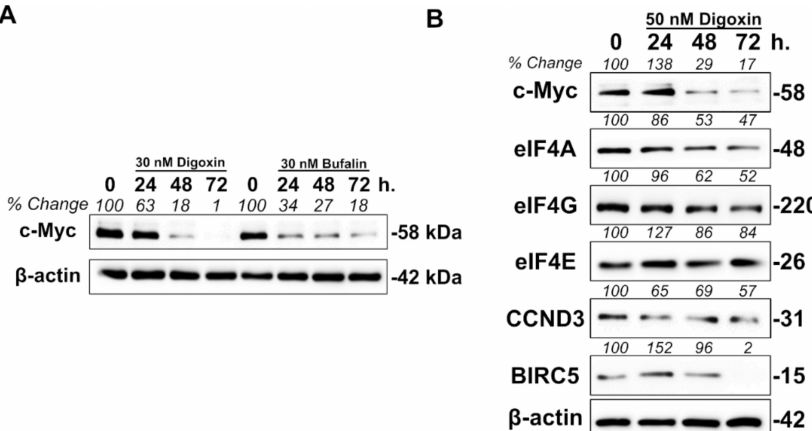
Figure 4. Cardiac glycosides modulate eIF4A expression levels through c-MYC ( A ). Western blot of BT20 cells following treatment with 30 nM of digoxin or bufalin for the indicated times. Band intensities were calculated by densitometry based on the ratio of c-MYC normalized to β -actin with 0 h set to 100 for each compound. ( B ). Western blot of SUM-159PT cells following treatment with 50 nM digoxin for the indicated times. Band intensities were calculated based on the ratio of each target normalized to β -actin with 0 h set to 100. Uncropped blots are shown in Figure